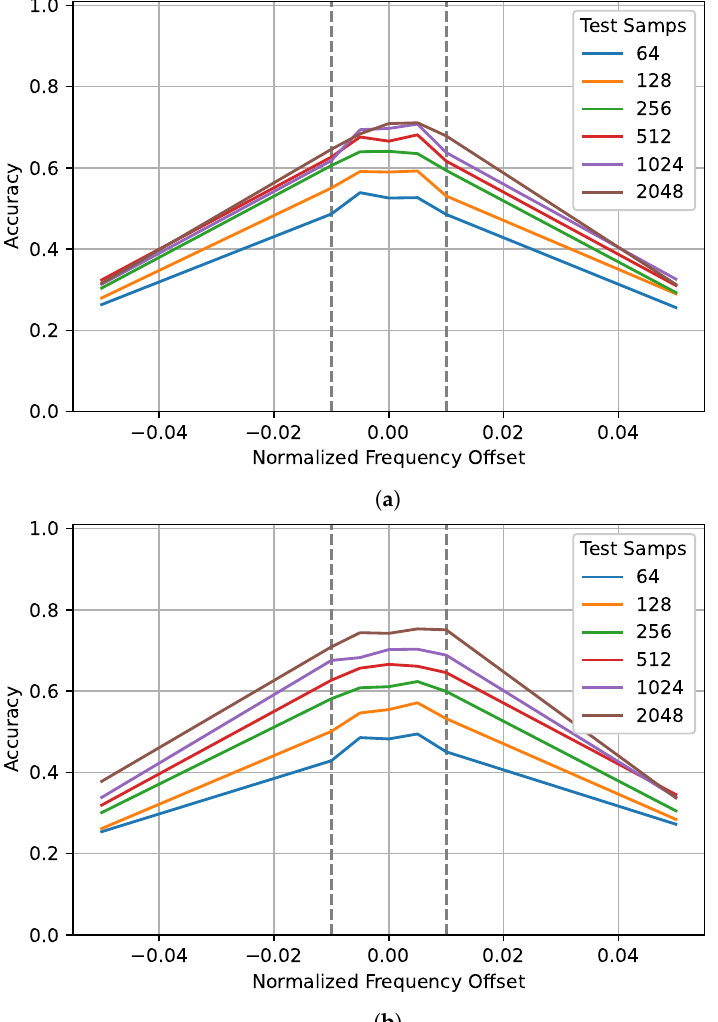
Figure 6. The impact of different training and testing sequence lengths on performance for different normalized frequency offsets. Sequence lengths of 64, 128, 256, 512, 1024, and 2048 were tested on the best network trained on ( a ) 128 samples and ( b ) 1024 samples. The gray dotted lines show the frequency training